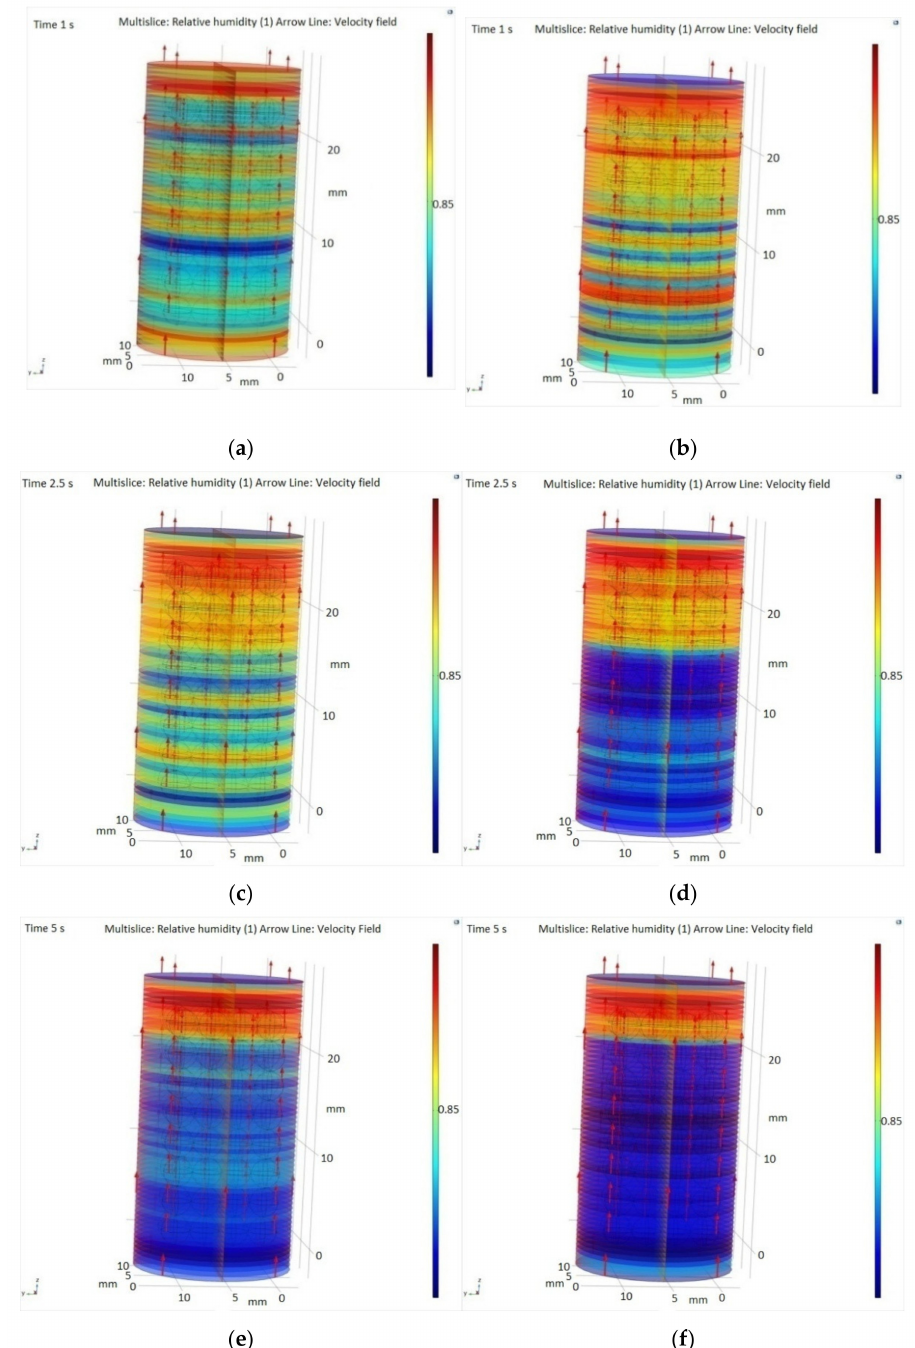
Figure 8. 3D concentration profile of the relative humidity and water vapors molecules trajectory in the SiO 2 bed along the z axis, at different time moments (t = 1, t = 2.5, and t = 5 s) and at a flow rate of 300 ( a , c , e ) and 600 sccm ( b , d , f